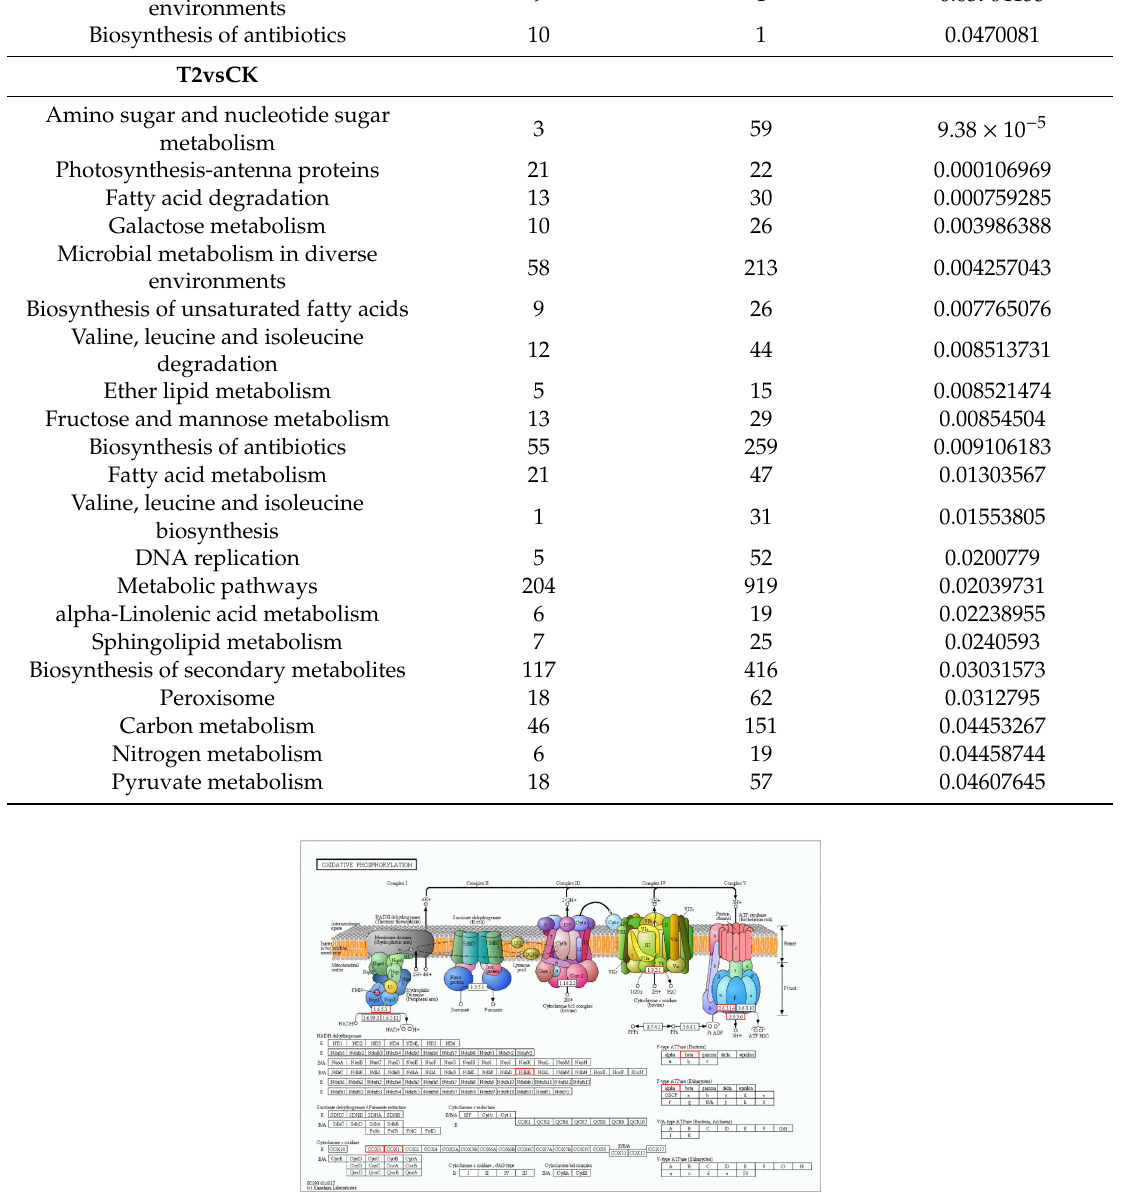
Figure 4. Di ff erentially expressed genes related to oxidative decarboxylation in C. pyrenoidosa under CK (control group) and T1 BPA (red color: upregulated